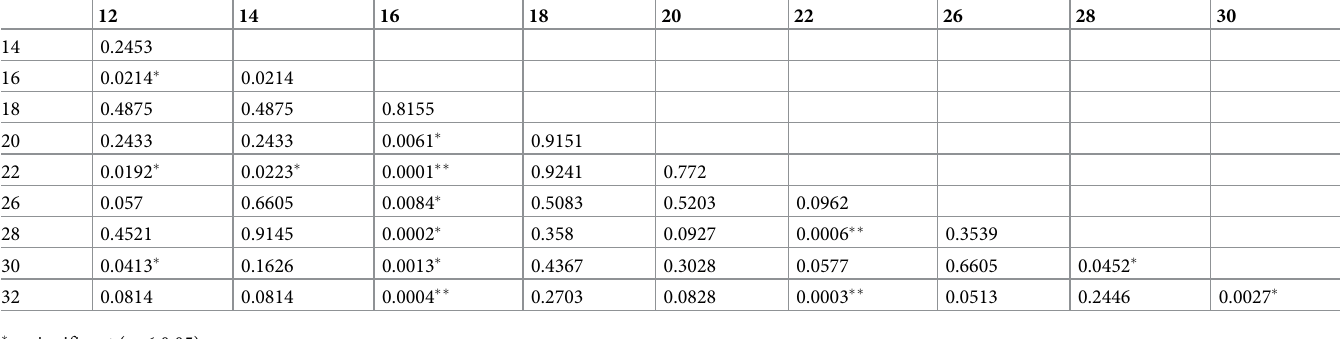
Table 3. Mann-Whitney tests (Bonferroni corrected) for all pairwise comparisons of chromosome numbers of 2n = 16 and 2n = 22 with any other chromosome numbers except 2n = 18 and 2n =